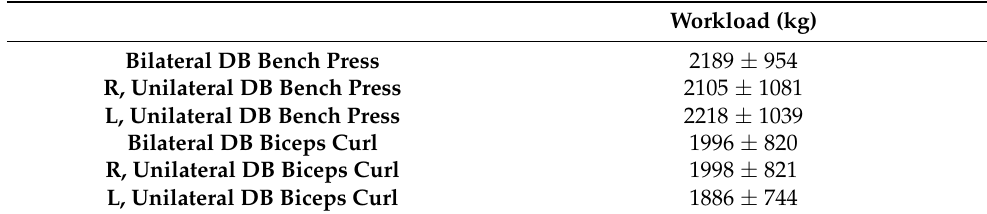
Table 2. Bilateral and unilateral upper body acute resistance exercise workloads ( n = 14; Men = 7; Women = 7).